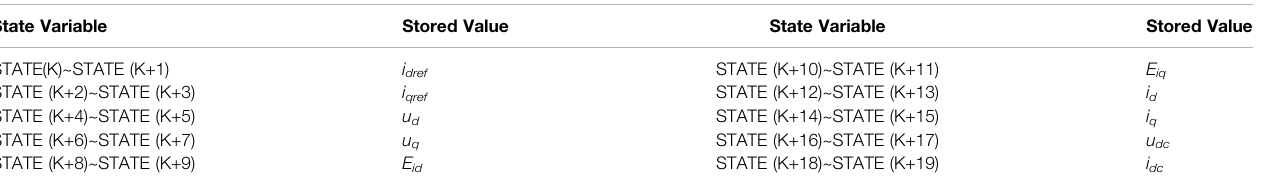
TABLE 4 | Storage allocation of STATE array for MMC-HVDC.